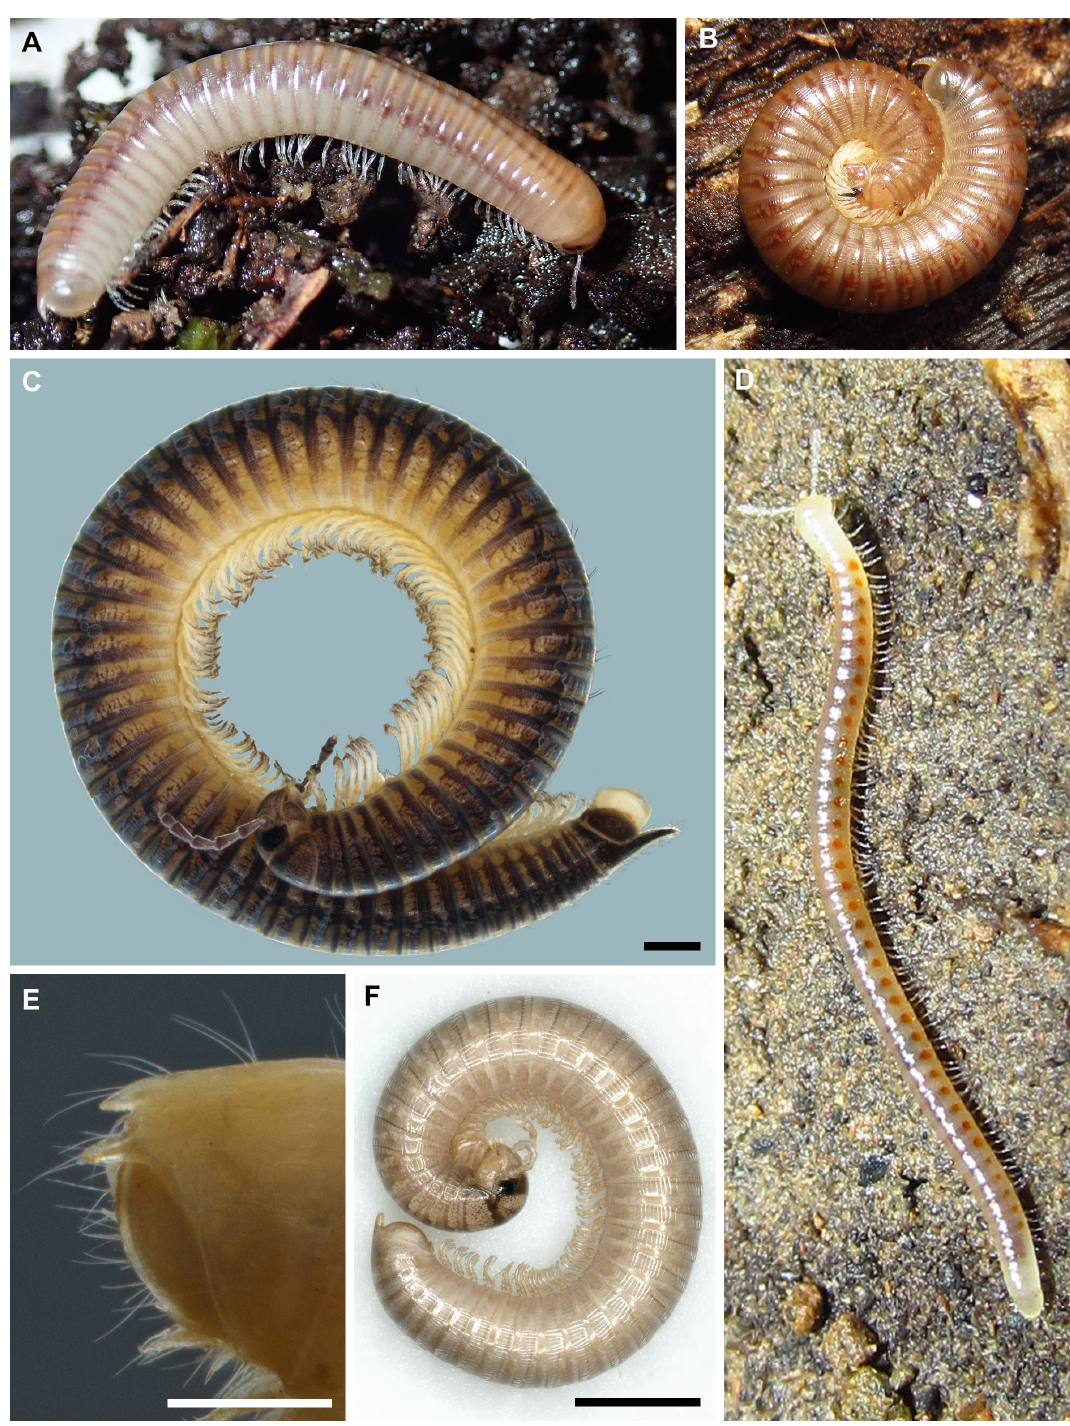
Fig. 53. A – B . Chromatoiulus podabrus (Latzel, 1884), in situ , specimens from near Trebinje, Bosnia and Herzegovina (photos: Marjan Komnenov (A); Dragan Antić (B)). C . Nepalmatoiulus birmanicus (Pocock, 1893), habitus, lateral view, ♂ from Krabi, Thailand (IZB). D . Lamellotyphlus sotirovi Makarov, Mitić & Ćurčić, 2002, in situ , topotype specimen from Buronov Ponor Cave (IZB) (photo: Dragan Antić). E . Telsonius nycteridonis Strasser, 1976, lectotype ♂ from Nycteridon Cave, Greece (NMNHS 10810), telson, dorsolateral view. F . Pteridoiulus aspidiorum Verhoeff, 1913, habitus, lateral view, ♂ from Nockberge, Austria (photo: Michaela Bodner). Scale bars: C, F = 1 mm; E = 0.5